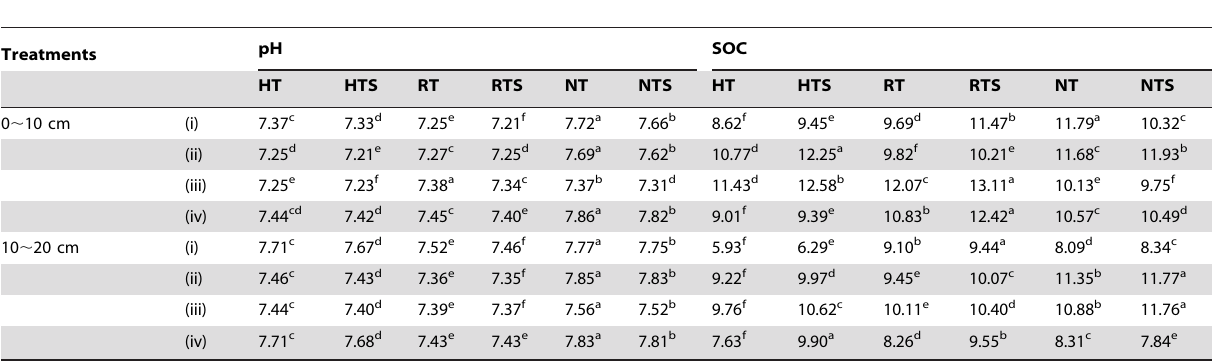
Table 3. Soil pH and SOC variations after conversion to